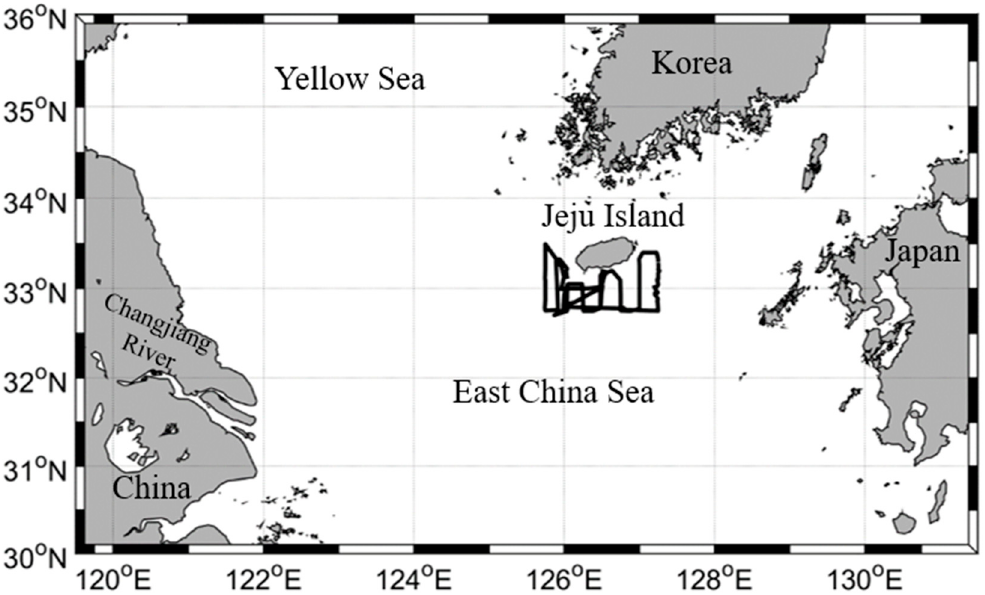
Figure 1. The study area and wave glider track in 2016 in the East China Sea.